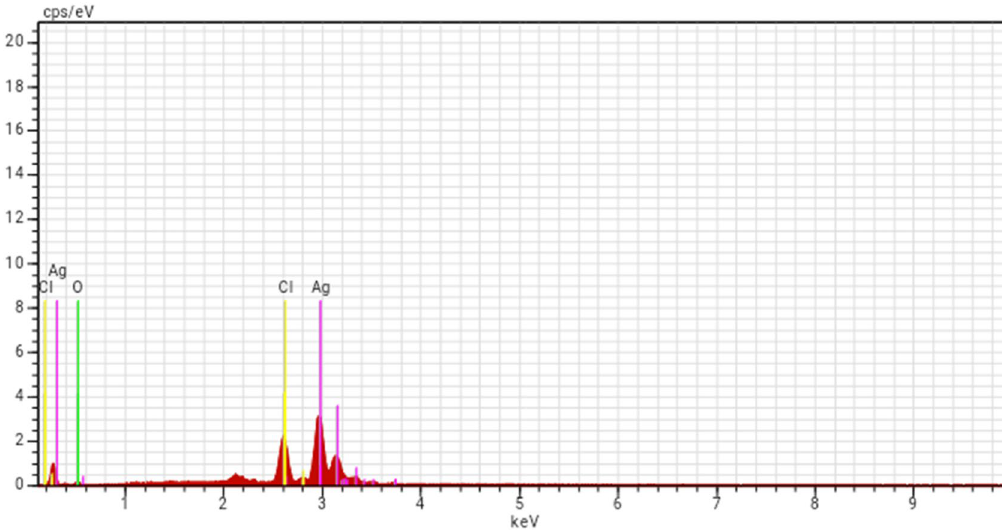
Figure 4. Energy-dispersive X-ray spectrum (EDX) of AgNPs fabricated sardine fish scale extract.